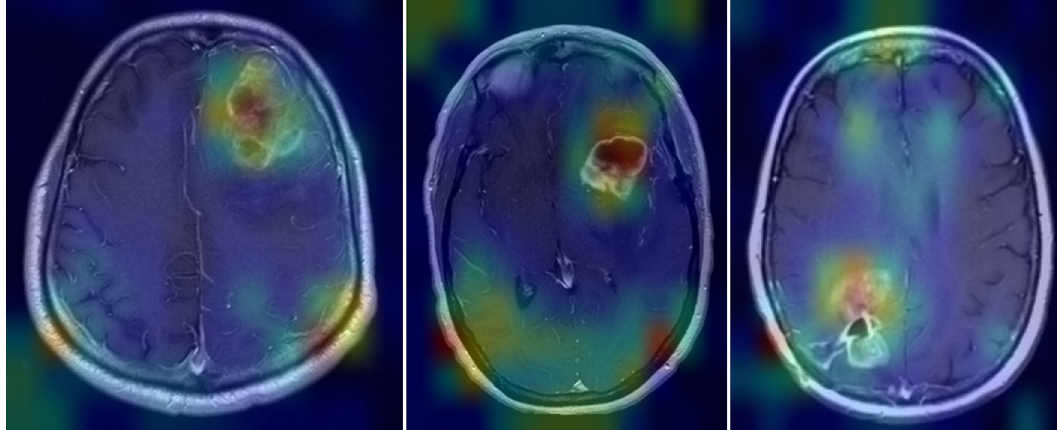
Figure 2. Heatmaps showing identifying features within the tumor that served as key determinants of